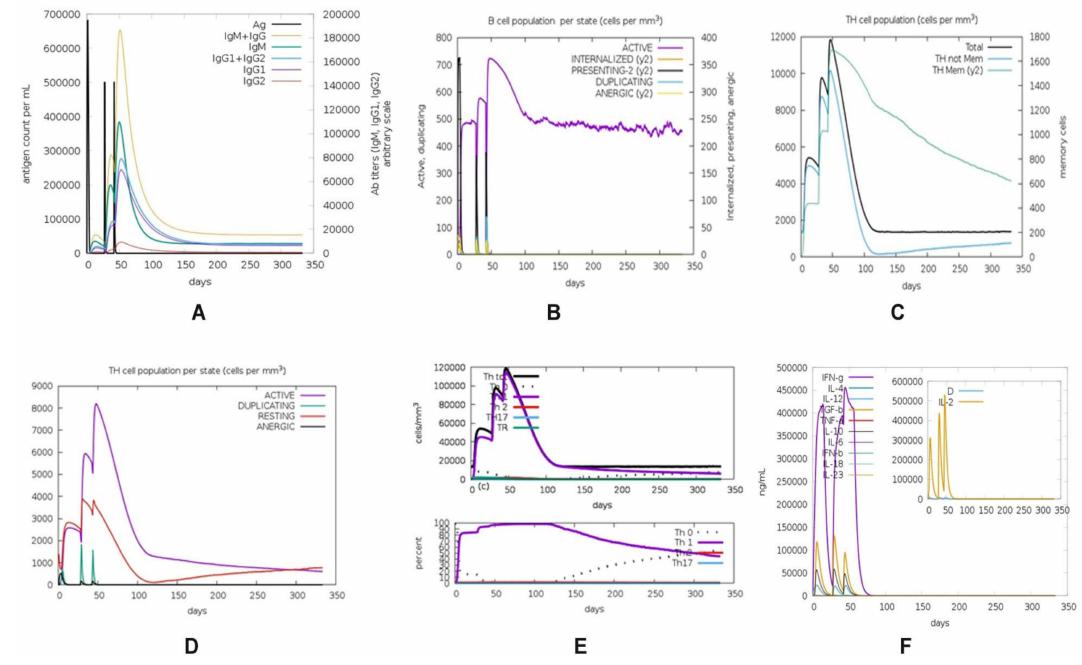
Figure 6. C-ImmSim presentation of an in silico immune simulation with the construct. ( A ) Immunoglobulin production in response to antigen injections (black vertical lines); specific subclasses are shown as colored peaks and ( B ) The evolution of B-cell populations after the three injections. ( C ) T-helper cell populations per state after the injections. ( D ) The evolution of T-cytotoxic cells. ( E ) Production of natural killer cells. The resting state represents cells not presented with the antigen while the anergic state characterizes tolerance of the T-cells to the antigen due to repeated exposures. ( F ) The main plot shows cytokine levels after the injections. The insert plot shows IL-2 level with the Simpson index. D is shown by the dotted line. D is a measure of diversity. Increase in D over time indicates emergence of different epitope-specific dominant clones of T-cells. The smaller the D value, the lower the